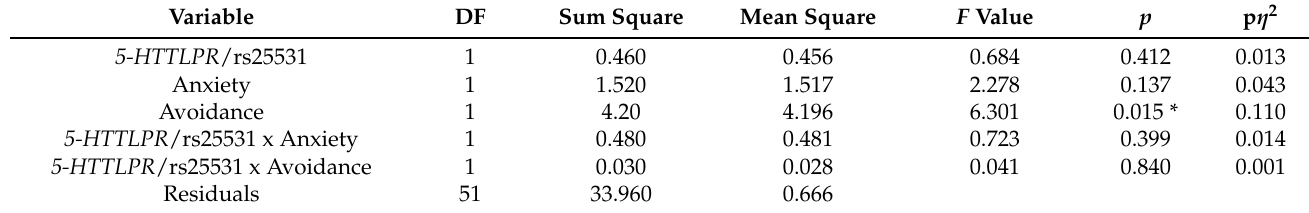
Table 2. Results and effect sizes of hypothesis-driven ANCOVA computed for Instagram number of followings. Degrees of freedom (DF), sum square, mean square, F value, p -value and partial eta squared (p η 2 ) are reported for main and interaction predictors. A significant main effects of avoidance was found on the number of followings. (* p < 0.05).